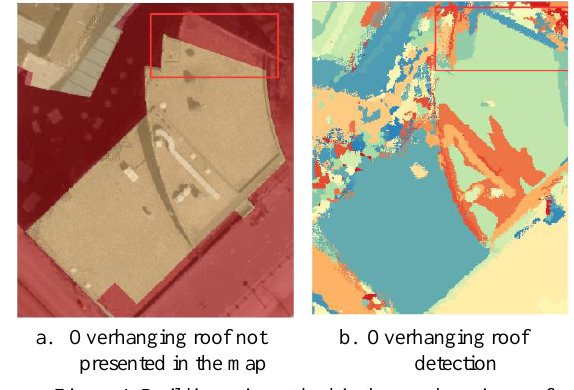
Figure 4. Building mismatched in the overhanging roof